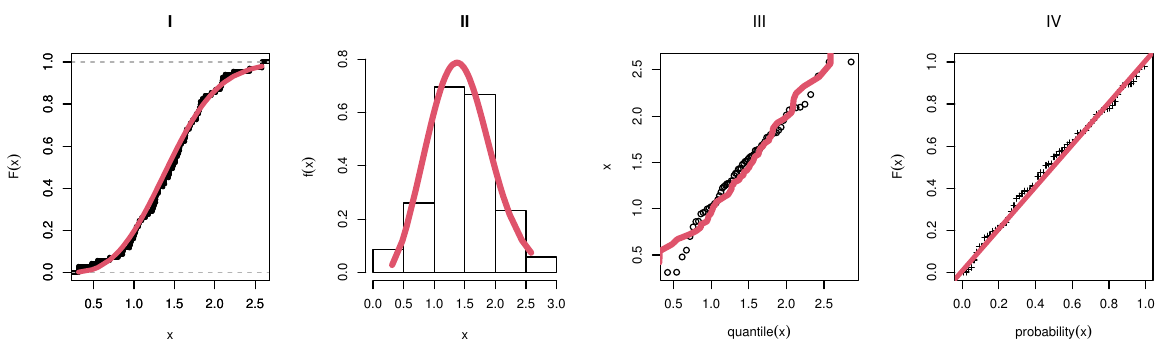
Figure 9. Fitting of ( I ) ecdf, ( II ) epdf, ( III ) QQ and ( IV ) PP plots for the carbon fibre data.